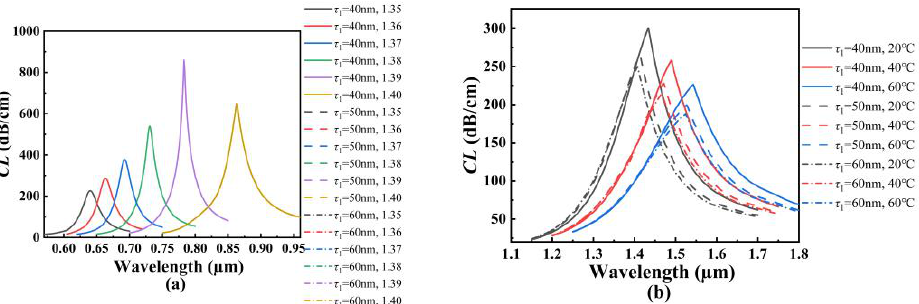
Figure 8. ( a ) The CL spectra of the core mode A when τ 1 is set as 40, 50, and 60 nm, and when the analyte RI increases from 1.35 to 1.40, respectively. ( b ) The CL spectra of the core mode B when τ 1 is set as 40, 50, and 60 nm, and when the temperature is chosen as 20, 40, and 60 °C,